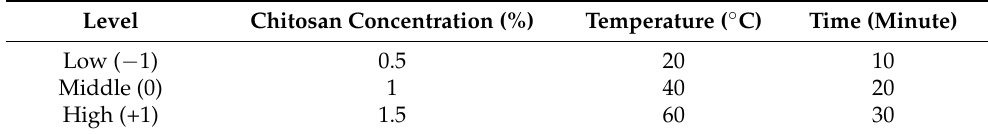
Table 2. Level of experimental variables.